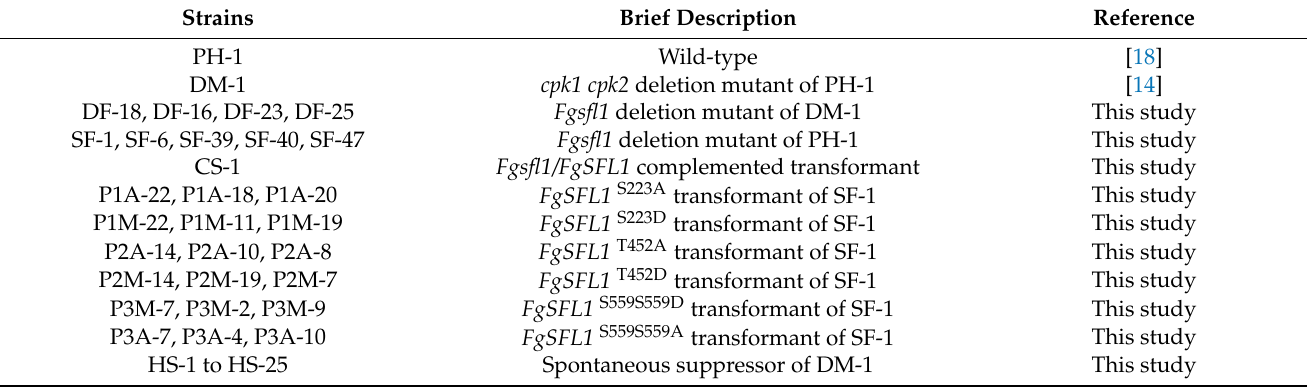
Table 1. Wild-type and mutant strains of F. graminearum used in this